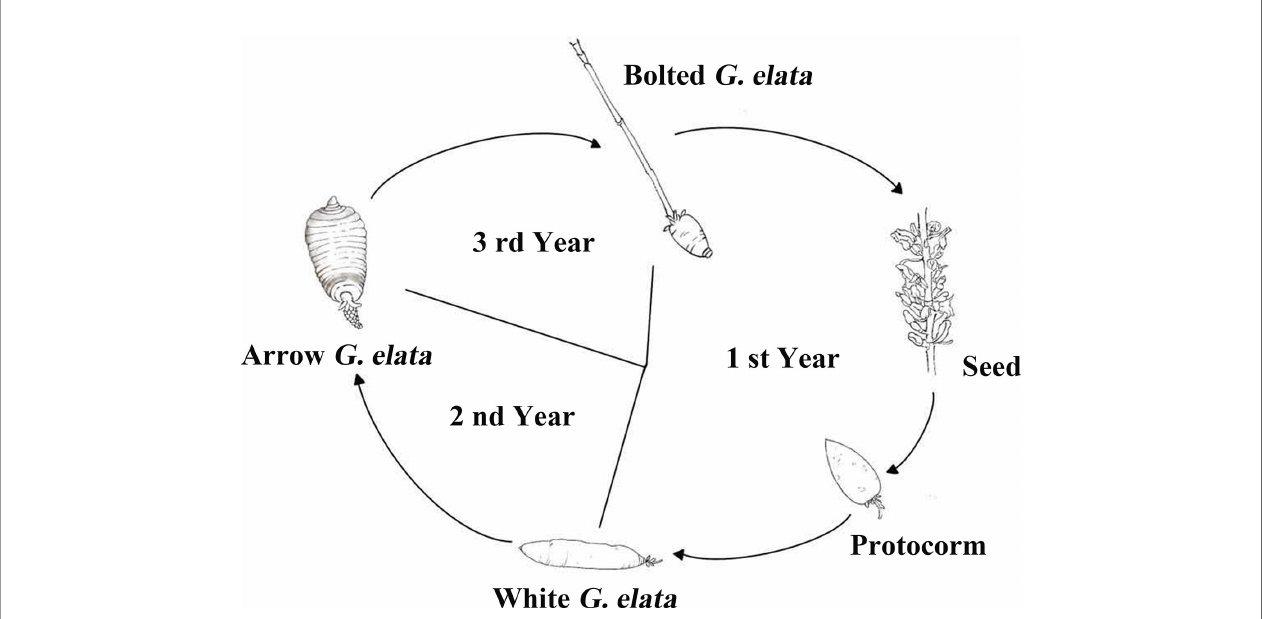
FIGURE 1 | The life cycle of G. elata (trace diagram). The life cycle of G. elata has fi ve stages, including G. elata seeds, protocorms, white G. elata , arrow G. elata , and bolted G. elata